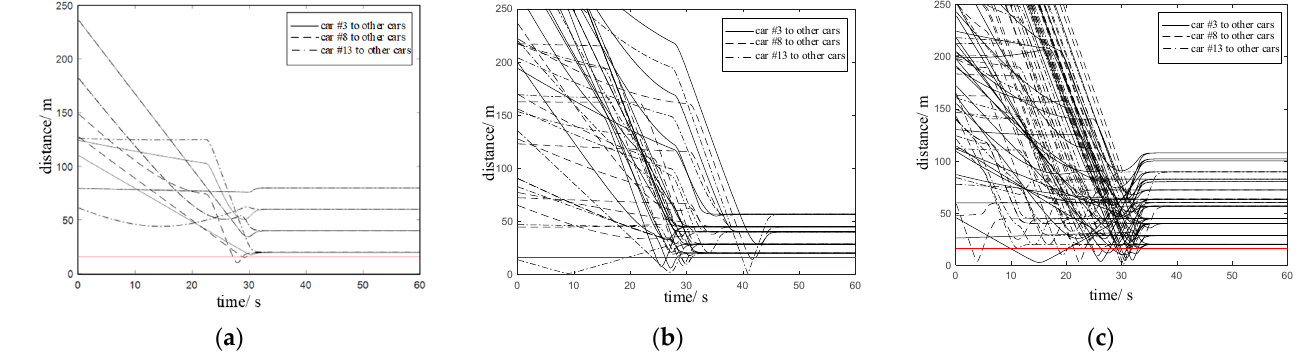
Figure 7. The distance changes with time between some vehicles and other vehicles under different numbers of vehicles. ( a – c ) represent the distance changes for 5, 15, and 30 vehicles, respectively.